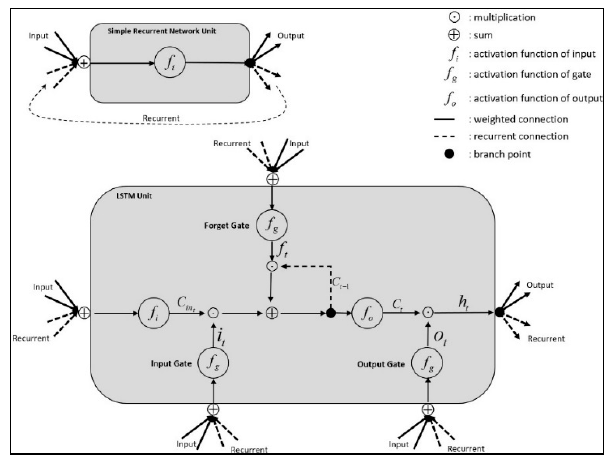
Figure 7. The Long Short-Term-Memory (LSTM) unit and simple recurrent network unit.